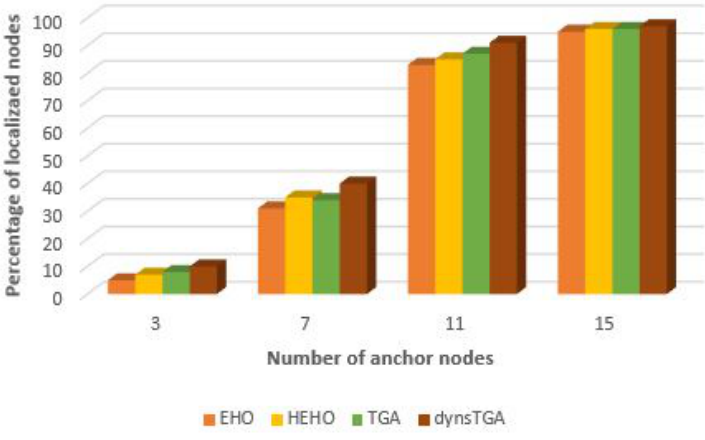
Figure 10. Percentage of localized nodes vs. number of anchor